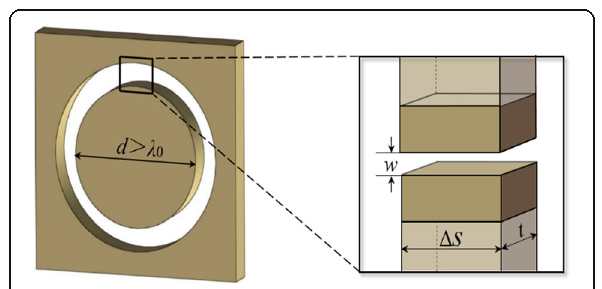
Fig. 1 The MIM waveguide model of an individual nanoring embedded in the gold film. The inset gives an enlarged view of an arbitrary small portion of the nanoring